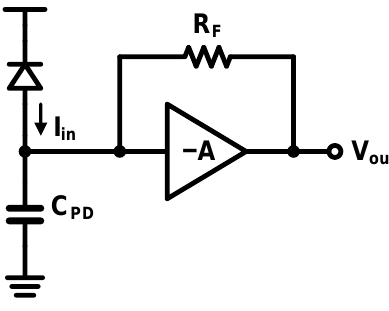
Figure 25. Shunt-shunt feedback TIA.